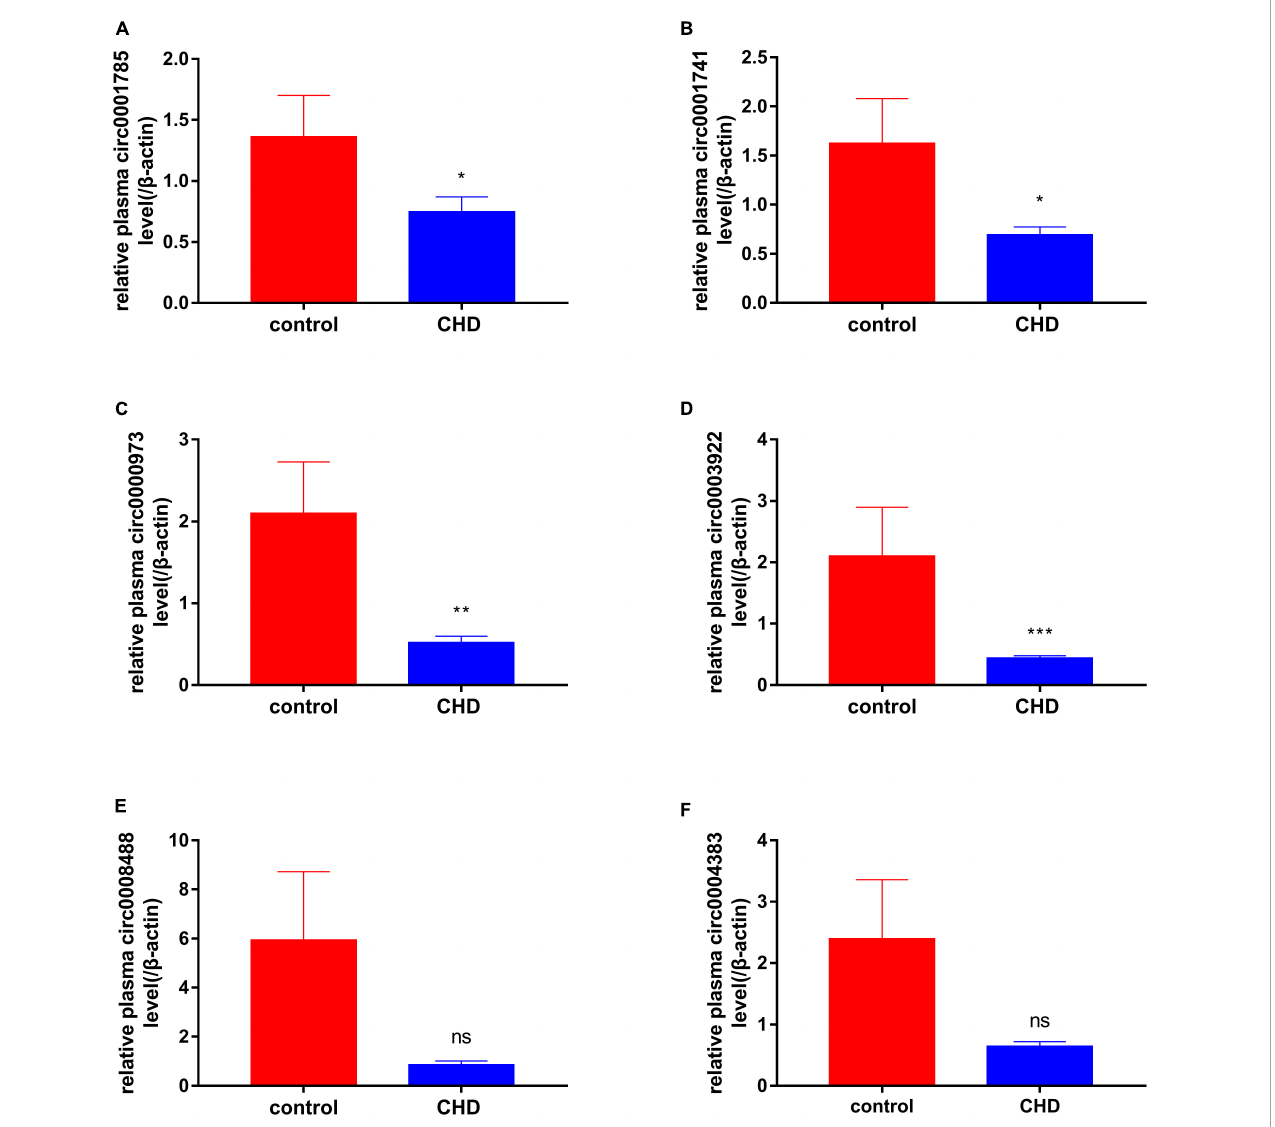
FIGURE7 qRT-PCR results of peripheral blood-derived circRNA. The expressions of peripheral blood-derived circRNAs were further confirmed using qRT-PCR. (A) Represents the expression of circ0001785 in white blood cells of healthy and coronary patients, (B) represents the expression of circ0001741 in white blood cells of healthy and coronary patients, (C) represents the expression of circ0000973 in white blood cells of healthy and coronary patients, (D) represents the expression of circ0003922 in white blood cells of healthy and coronary patients, (E) represents the expression of circ0008488 in white blood cells of healthy and coronary patients, and (F) represents the expression of circ0004383 in white blood cells of healthy and coronary patients. Red represents healthy control group, blue represents coronary heart disease (CHD) group, P < 0.05 was statistically significant. * P < 0.05, ** P < 0.01, and *** P <